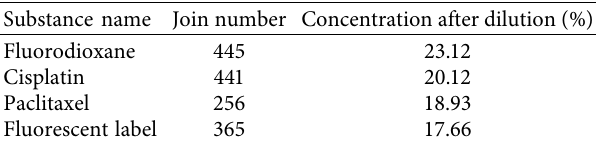
Table 3: Comparison of concentrations of different substances after